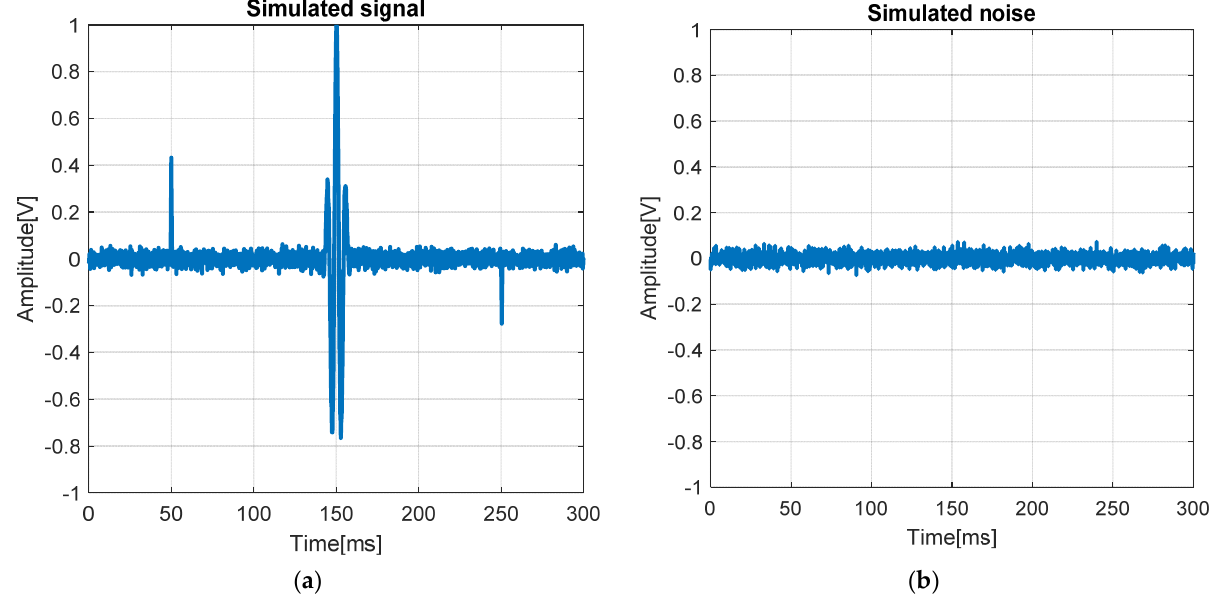
Figure 2. ( a ) The simulated network signal; ( b ) the simulated noise.